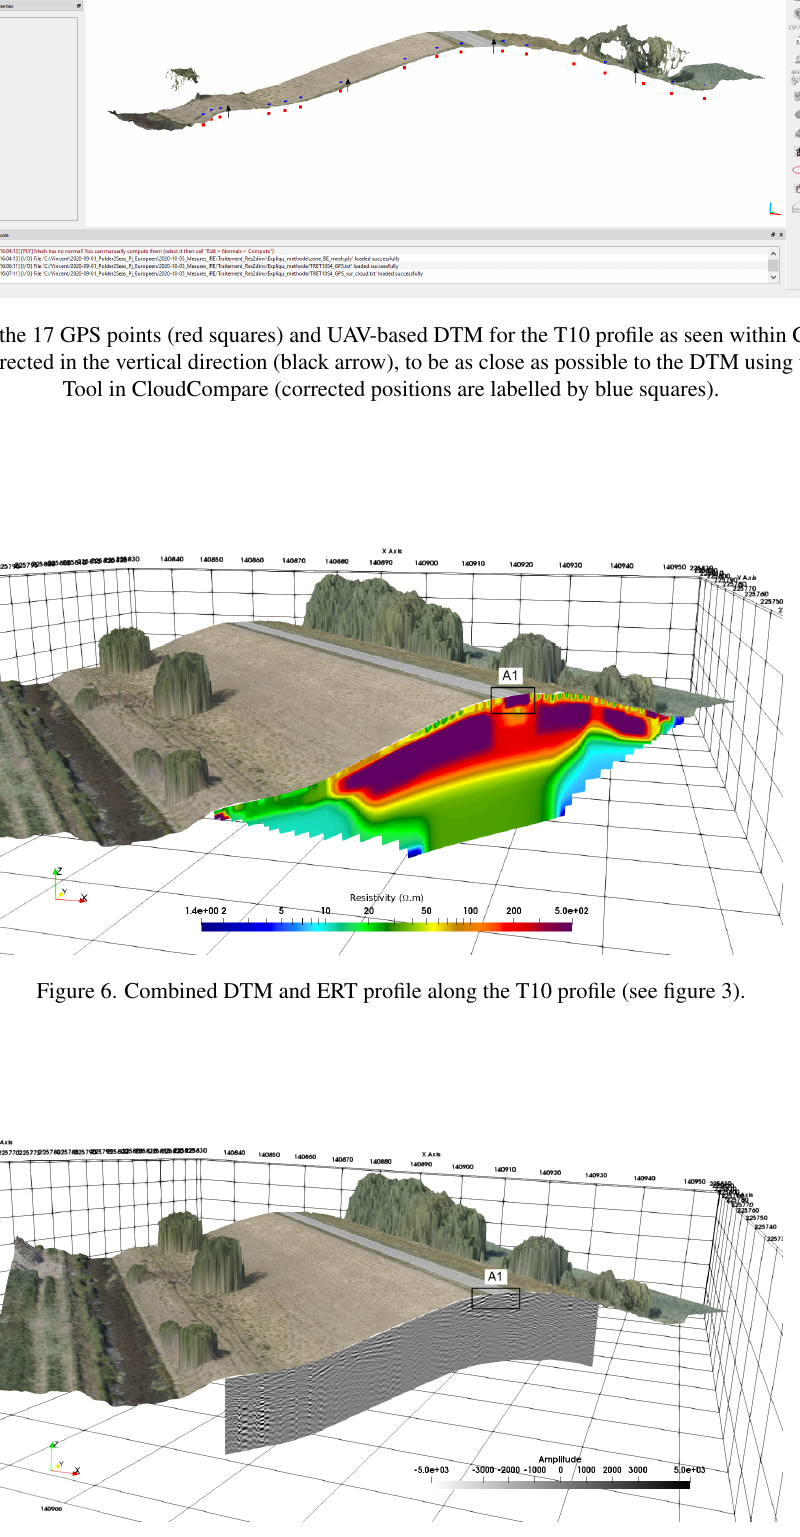
Figure 7. Combined DTM and GPR profile along the T10 profile (see figure